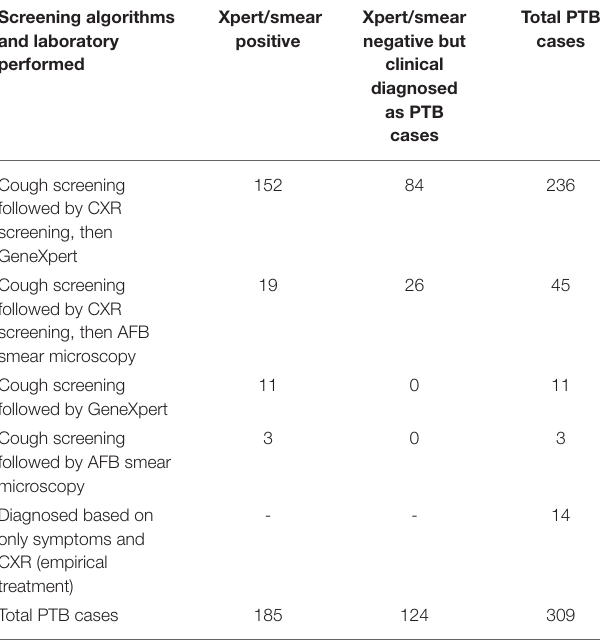
TABLE 3 | Pulmonary TB case finding algorithms of cough and/or chest X-ray screening then followed by Xpert/smear microscopy at health facilities, Ethiopia. Screening algorithms and